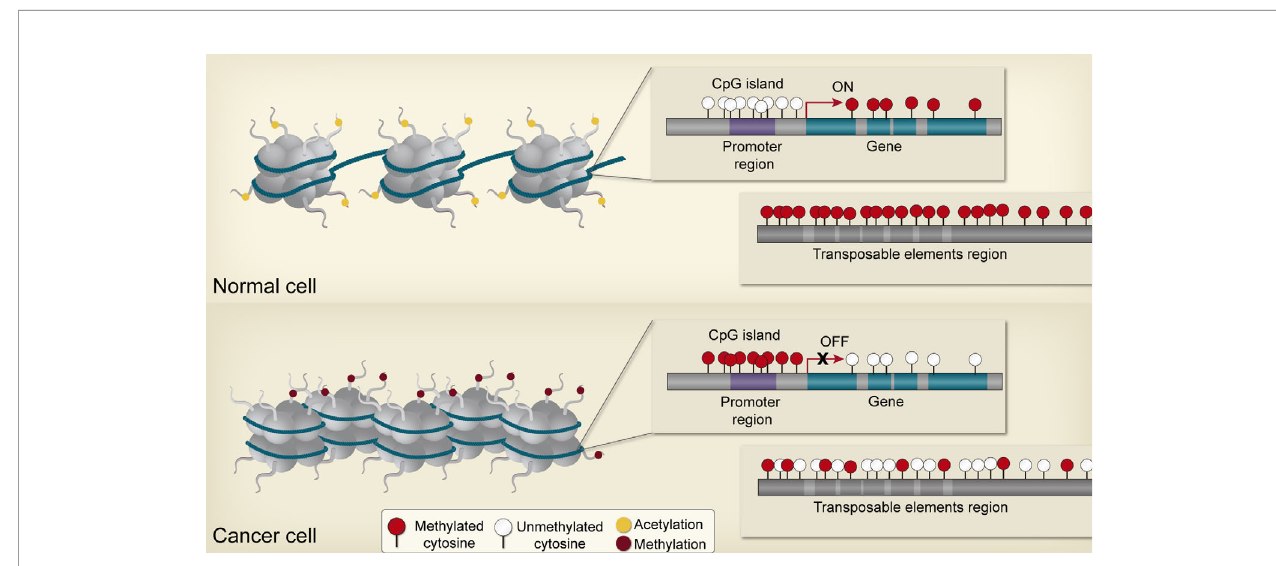
FIGURE 2 | Epigenetic alterations in cancer cells. In non-neoplasic cells, CpG islands of tumor suppressor gene promoters are generally unmethylated and acetylated, resulting in transcriptional activation and expression. In contrast, non-coding regions and repetitive elements are hypermethylated, ensuring chromosome stability. Gene bodies are normally methylated, enhancing transcription. Neoplasic cells are characterized by global hypomethylation and local CpG island hypermethylation, especially at tumor suppressor gene promoters, resulting in aberrant transcription and genomic